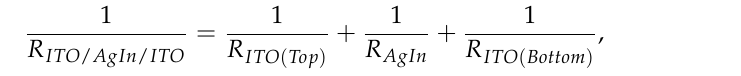
Figure 3. XRD patterns of as - cast, forging and final AgIn alloy targets .